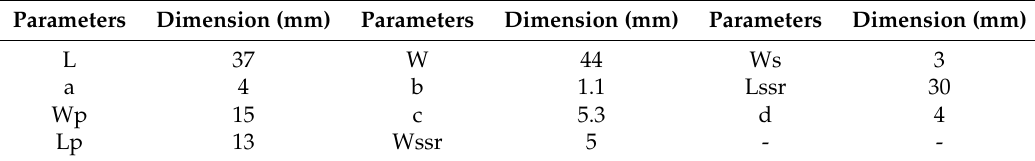
Table 1. Different Parameters and values of the